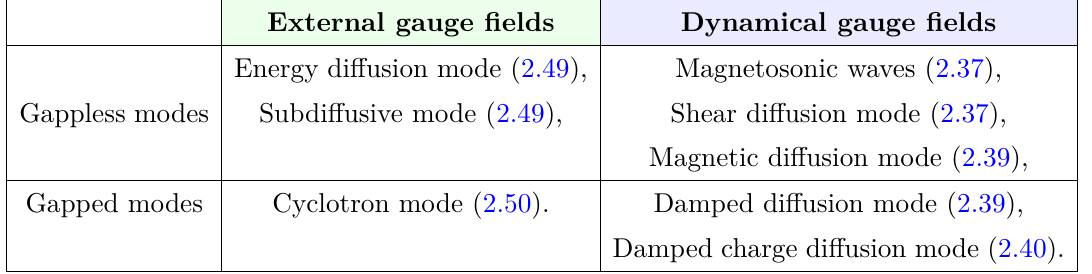
Table 1 . The low energy modes at zero density and finite magnetic field.